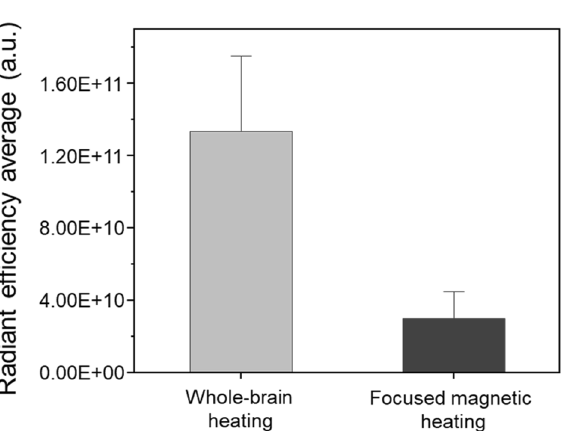
Figure 3. Average IVIS fluorescence value within ROI. Evans blue leakage inside the ROIs of the whole-brain (n = 10) and focused heating (n = 10) group were quantitatively evaluated. IVIS fluorescence by Evans blue leak to which a focused magnetic field was applied showed a more localized area than when the magnetic field was applied to the entire